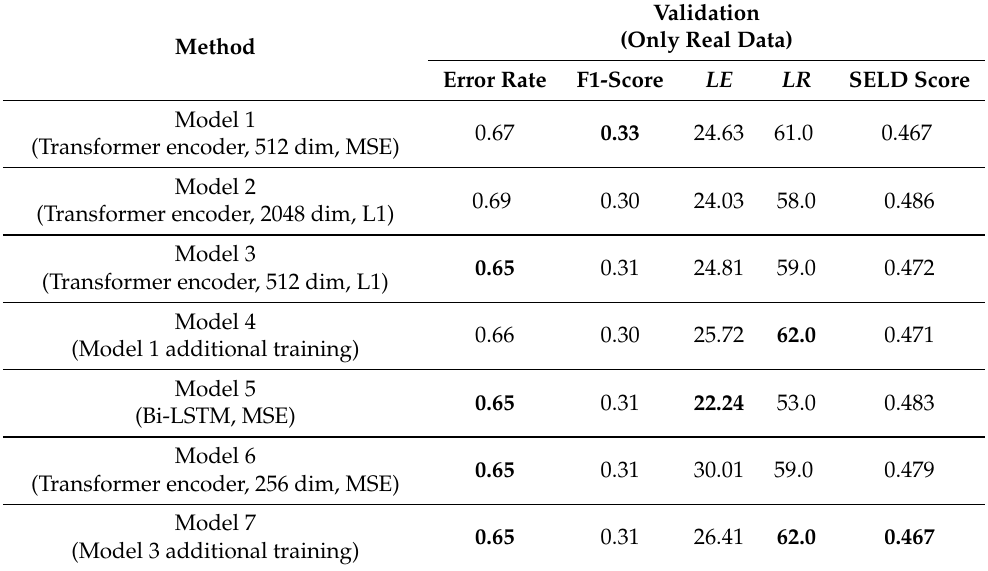
Table 2. Performance comparison of the trained single models. The values that have the best performance are bolded.